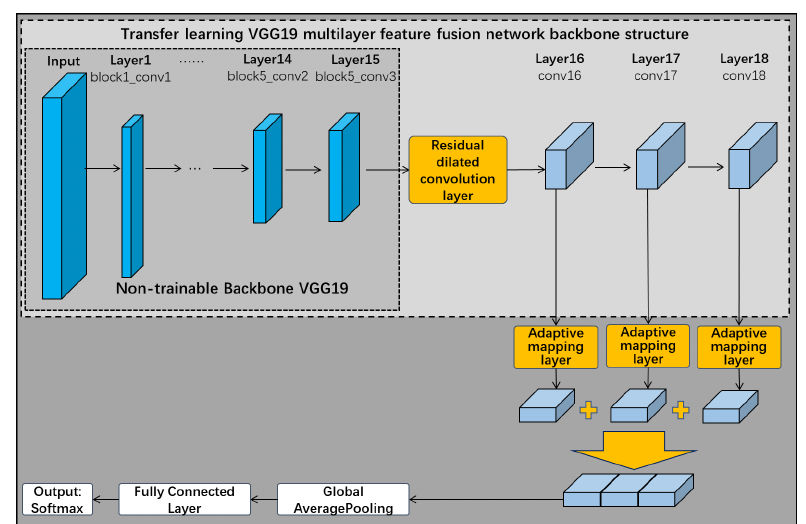
Figure 16. Improved residual dilated convolution multilayer feature fusion